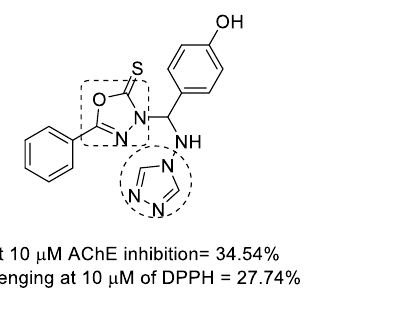
Figure 29. Chemical structures of oxadiazole – 1,2,3-triazole hybrids.